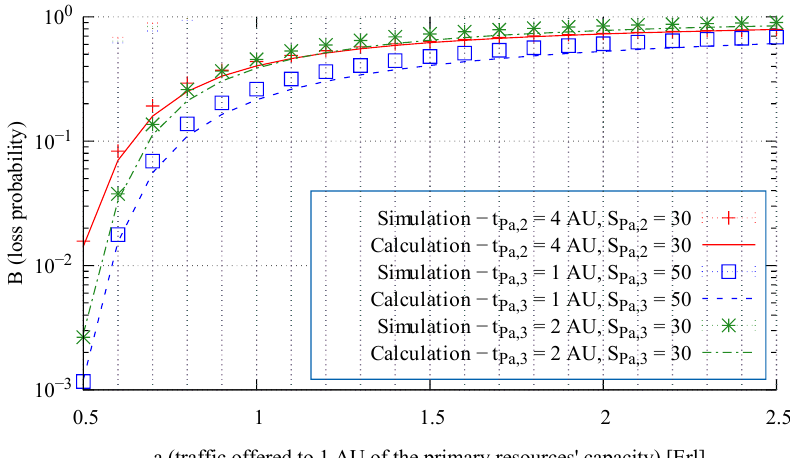
Figure 15. Loss probability (call congestion) of three selected traffic classes in the primary resources of System 1.